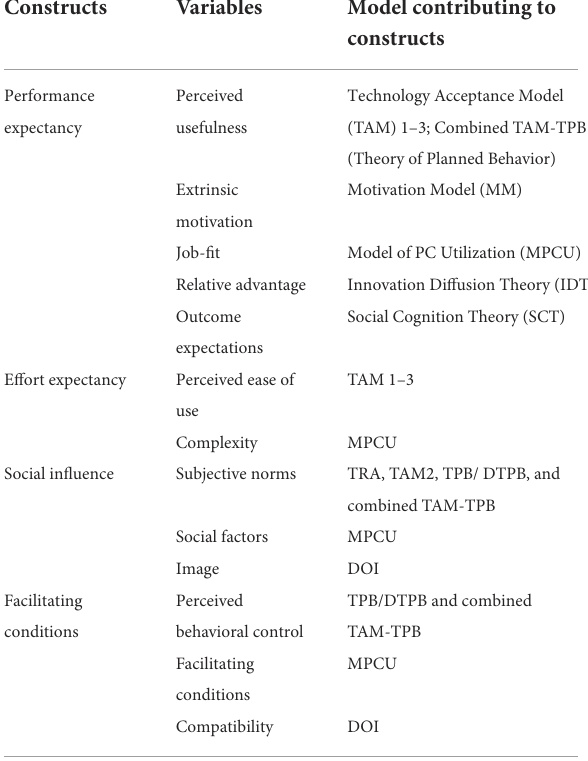
TABLE 1 Core constructs of